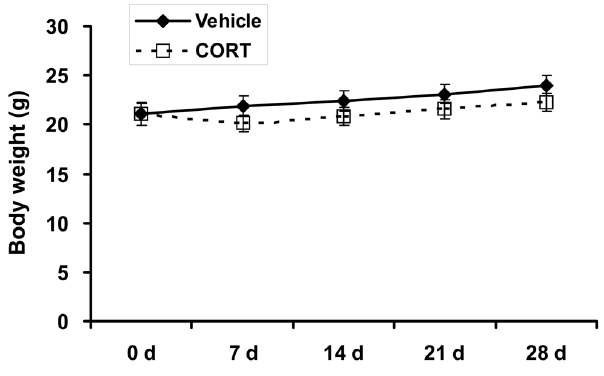
Figure 1. Effect of CORT on body weight of mice. Total body weight of mice treated with 100 m g/ml corticosterone (CORT) or vehicle during the experimental period. Data are expressed as group means 6 SEM (n=6 by group). * P , 0.05 compared with